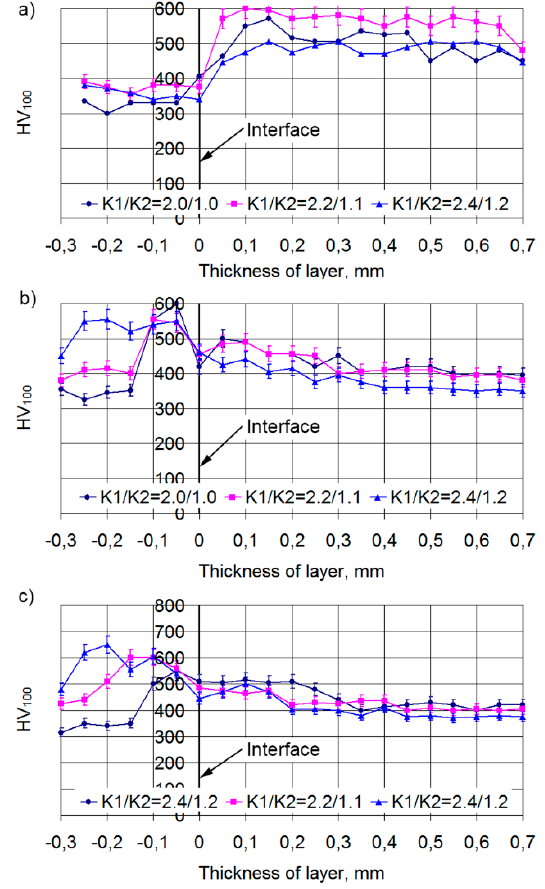
Figure 18. Microhardness distribution through the thickness of a double composite layer: ( a ) cladding speeds of Ni alloy / bronze VNi-al / Vbr = 100 / 150 mm / min; ( b ) cladding speeds of Ni alloy / bronze VNi-al / Vbr = 120 / 180 mm / min; ( c ) cladding speeds of Ni alloy / bronze VNi-al / Vbr = 140 / 210 mm / min.